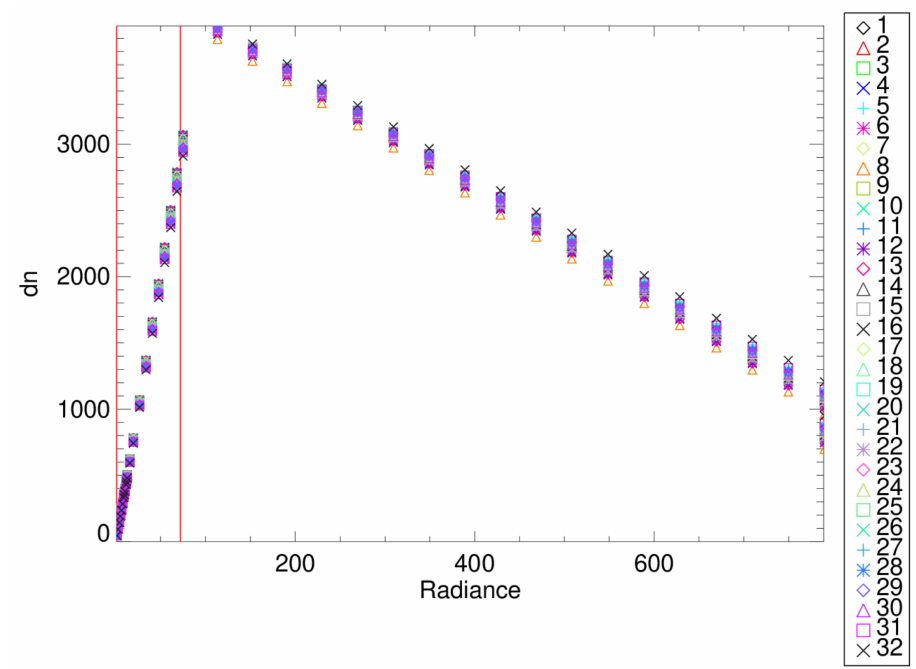
Figure 5. Band I3 dynamic range measurements for all detectors, legend in the upper right, for HAM side A. The y-axis is offset subtracted VIIRS response, and the x-axis is the SIS100 radiance during the measurement. The second vertical red line corresponds to Lmax. The rollover in the response is due to saturation of the focal plane electronics. This causes two unique radiance levels to produce the same VIIRS digital